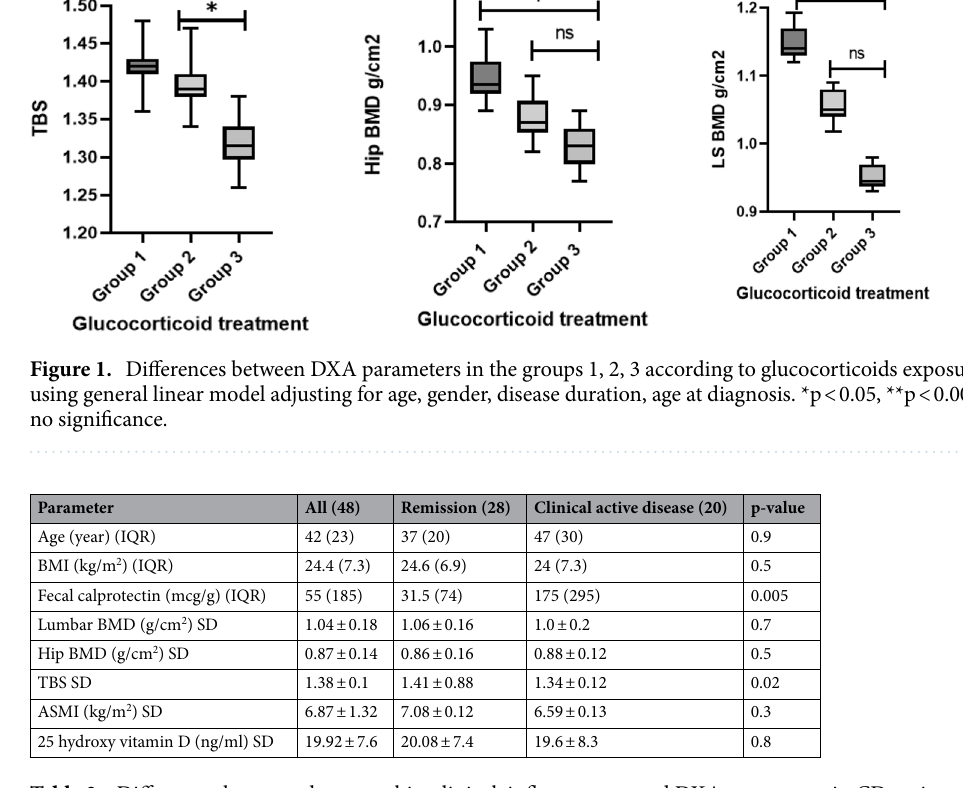
Table 3. Differences between demographic, clinical, inflammatory and DXA parameters in CD patients. Values are presented as mean ± SD or median (IQR), number, according to the type of variable and the normality of distribution. p-value presented statistically significant differences p < 0.05. BMI body mass index BMD bone mineral density, TBS trabecular bone score, ASMI appendicular skeletal muscular index.